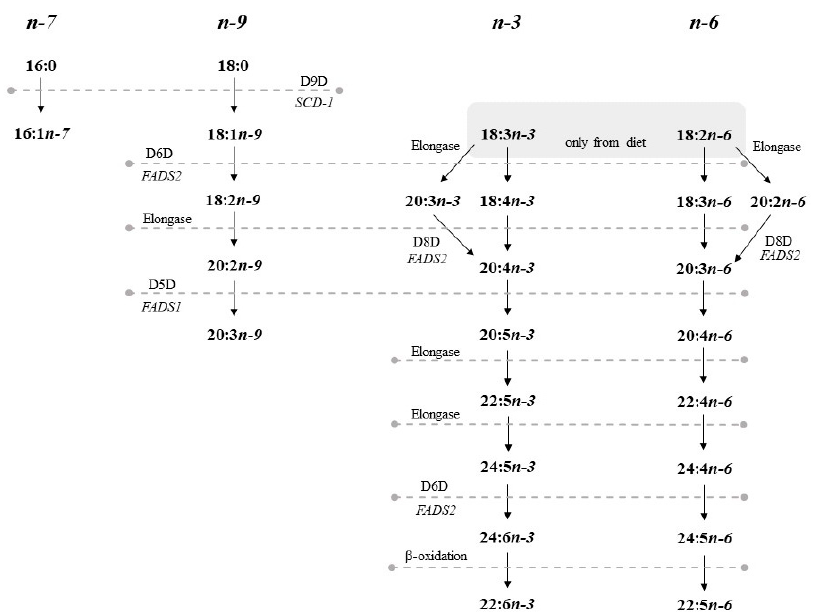
Figure 1. Endogenous pathways of polyunsaturated fatty acids (PUFA) metabolism in mammals. D5D: Delta-5 desaturase; D6D: Delta-6 desaturase; D8D: Delta-8 desaturase; D9D: Delta-9 desaturase; SCD-1: Stearyl-CoA desaturase 1; FADS1 : Fatty acid desaturase 1; FADS2 : Fatty acid desaturase 2; PUFA: Polyunsaturated fatty acids.